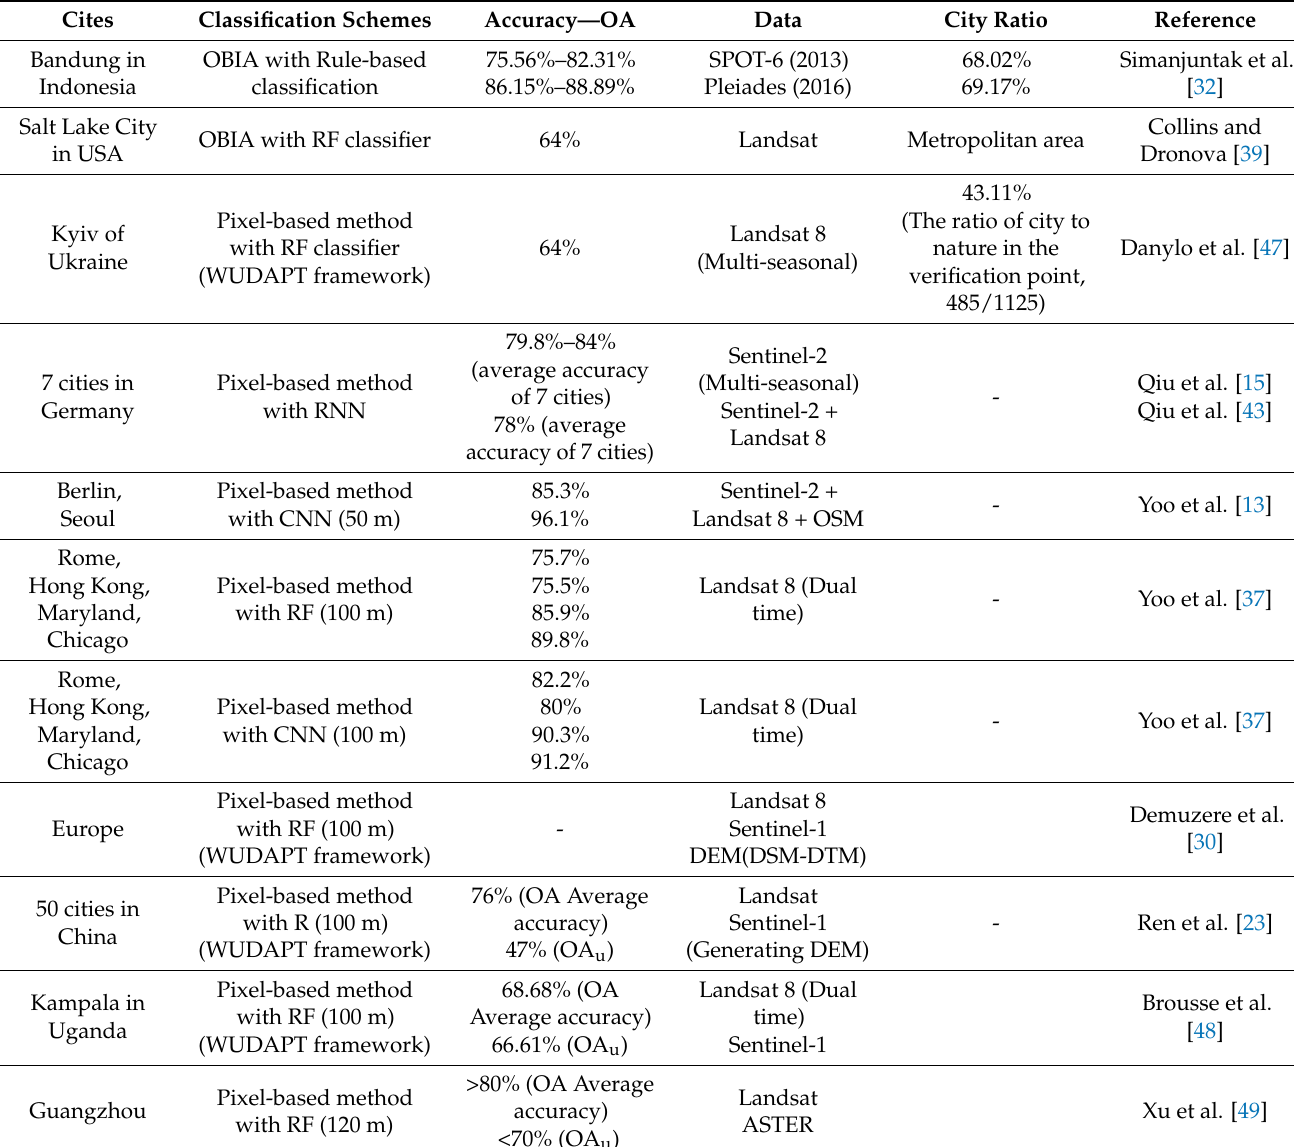
Table 2. Typical research examples of LCZ